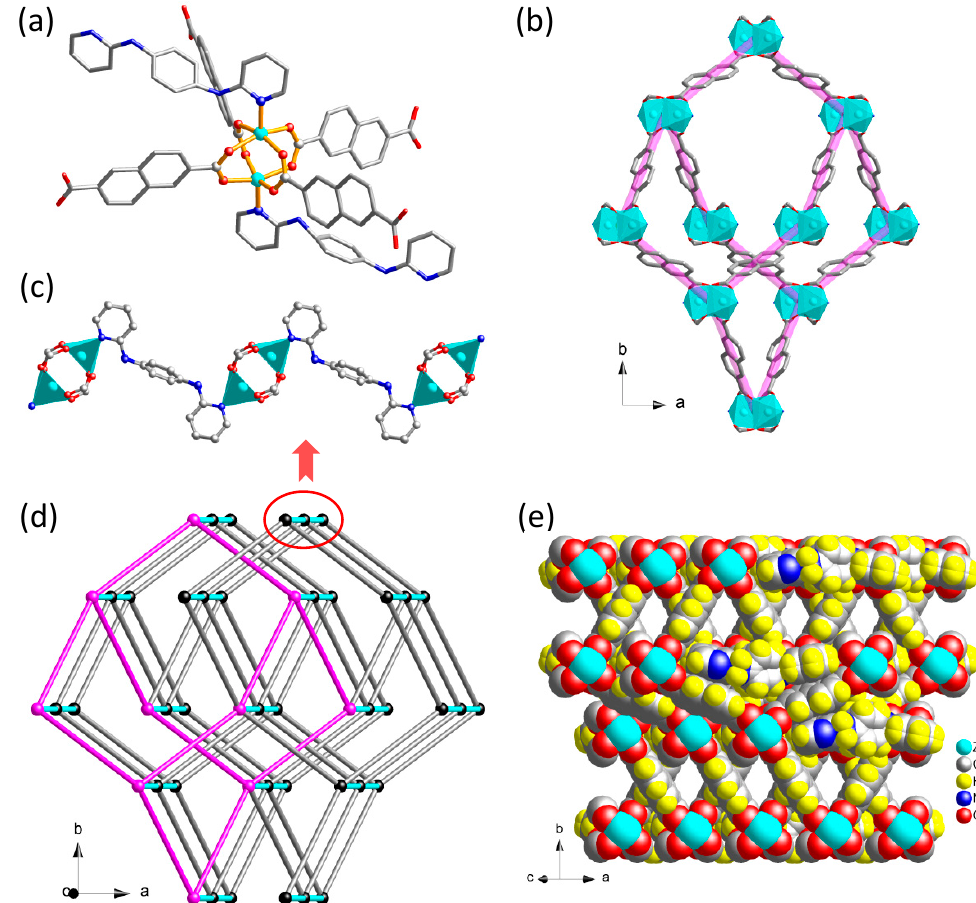
Figure 1. Molecular structure of 1 : ( a ) coordination environment of Zn(II) atom; ( b ) the Zn–2,6-ndc diamondoid network; ( c ) the linear chain consisting of {Zn 2 (COO) 4 } secondary building units (SBUs) and 2-Pn bridges; ( d ) the whole 6-connected non-interpenetrated framework with Schläfli symbol of 4 8 · 6 7 topology; ( e ) packing diagram viewed down the crystallographic [101] direction, showing the solvent-accessible